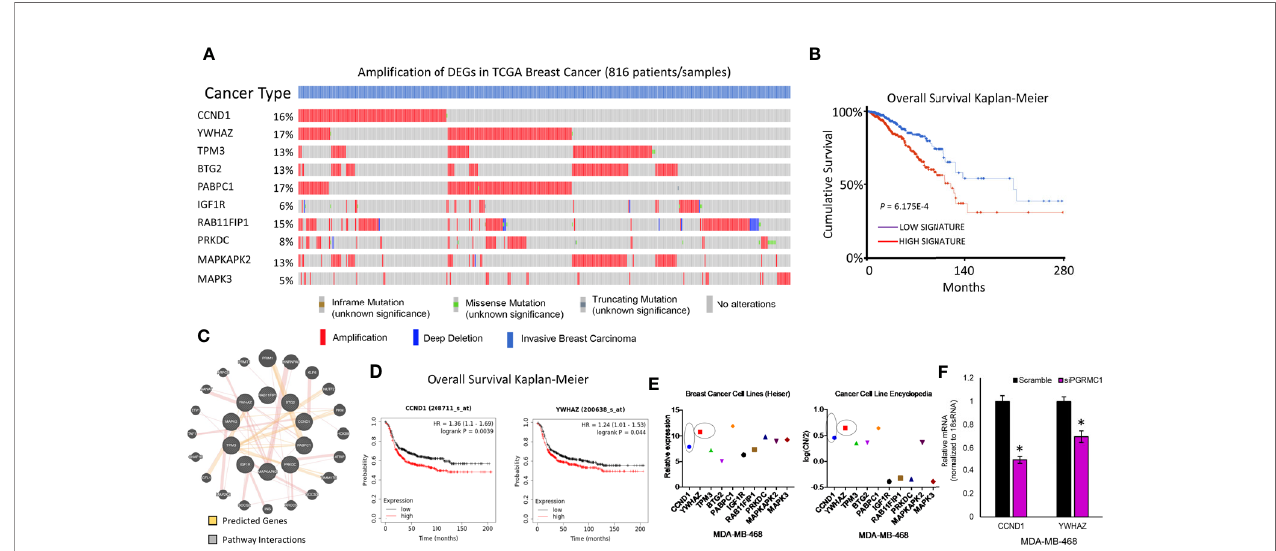
FIGURE 7 | PGRMC1 impairment identi fi ed miRNA target genes to be ampli fi ed in invasive breast carcinoma patients. (A) Oncoprint illustrates genetic alterations such as inframe mutations, missense mutation, truncating mutation, ampli fi cation and deep deletion of breast cancer tumor samples (n=816). miRNA target genes that had a greater than 5% genetic alteration were considered for further analysis . (B) Cumulatively patient samples that have high signature/expression of miRNA target genes exhibiting > 5% genetic alterations are associated with poorer overall survival. (C) Network analysis links the top ten miRNA target genes with associated pathway interactions and predicts interactions within known pathways. (D) The top two miRNA target genes, CCND1 and YWHAZ are associated with signi fi cantly poorer overall survival in ER-negative breast tumor samples ( P < 0.05 was considered signi fi cant). (E) Increased relative gene expression and copy number variation of CCND1 and YWHAZ , are observed in MDA-MB-468 breast cancer cell lines. (F) Relative mRNA expression of CCND1 and YWHAZ in PGRMC1 silenced MDA-MB-468 cells. *P <